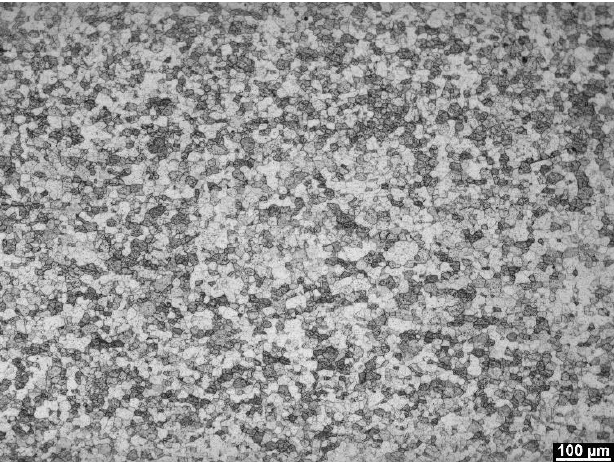
Figure 2. Microstructure of the base metal.